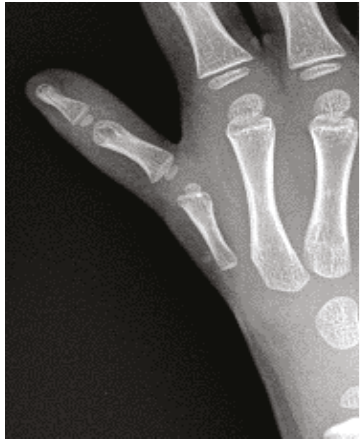
Figure 2: Radiographs demonstrating the type IIIB hypoplastic thumb.